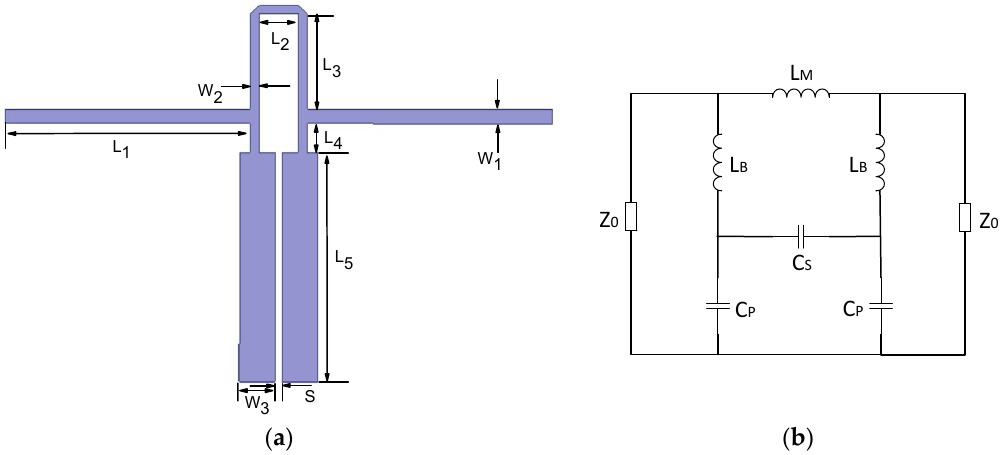
Figure 5 . ( a ) Layout of LPF constructed by SIR hairpin with internal coupling; ( b ) equivalent circuit diagram of microstrip LPF.